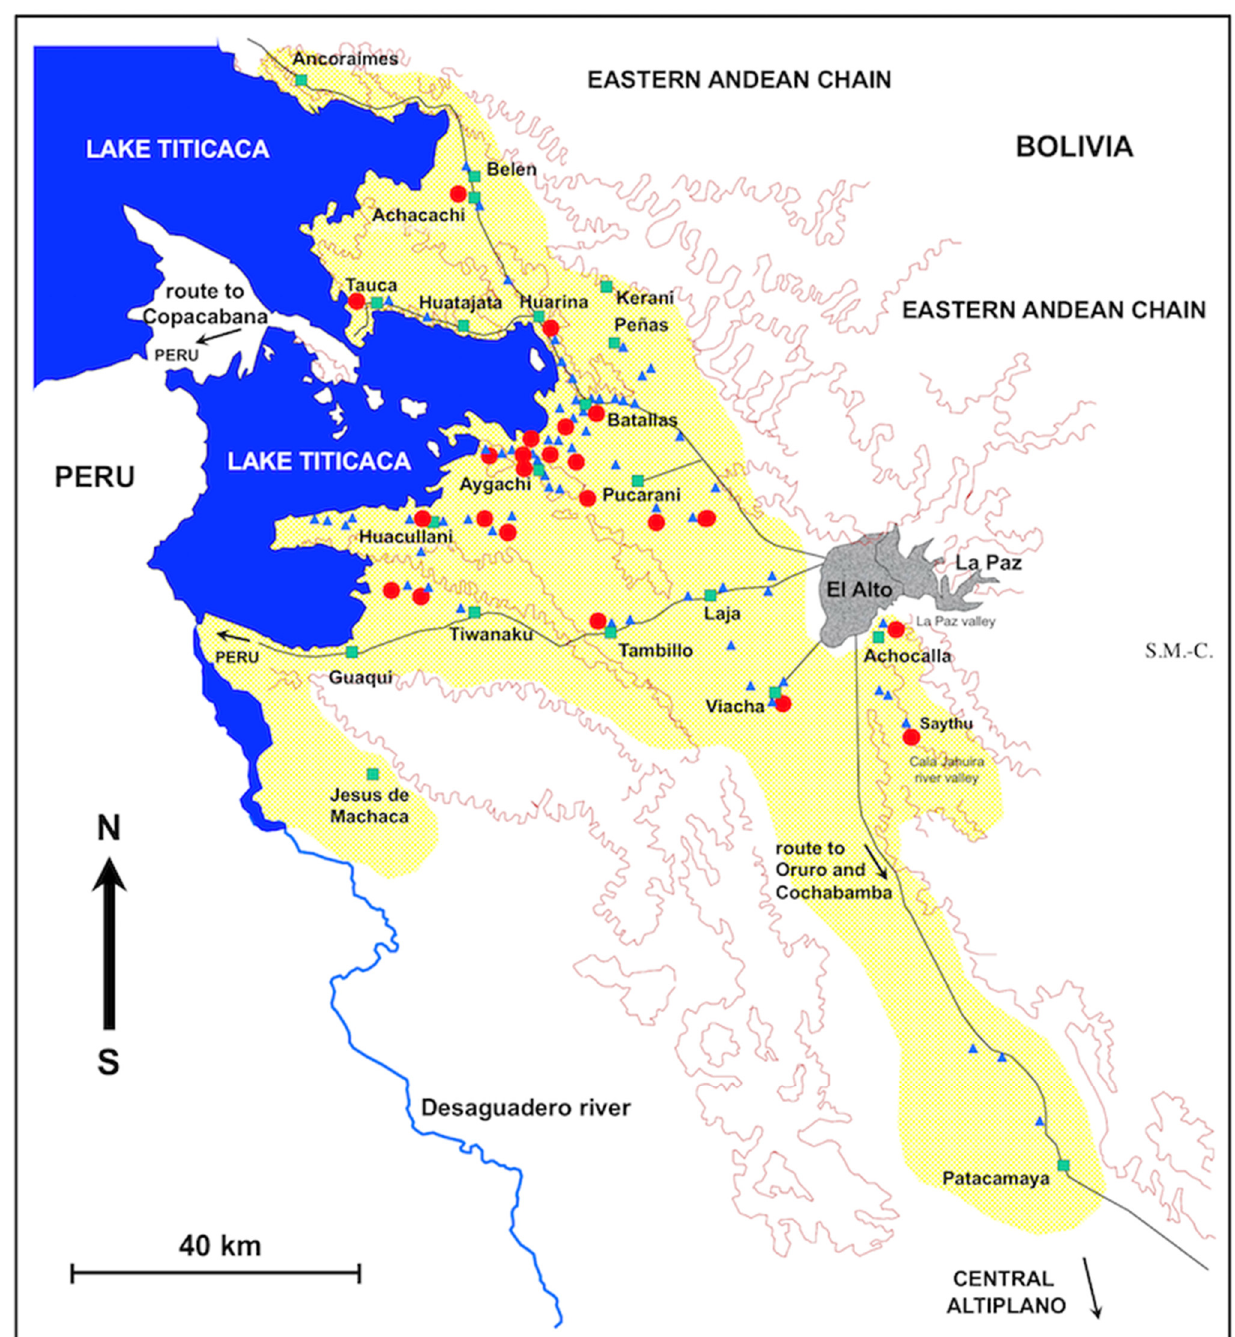
Figure 1. Map of the human fascioliasis hyperendemic area in the Northern Bolivian Altiplano, between Lake Titicaca and the city of El Alto and the valley of La Paz city: Yellow background = total prospected zone; red circles = localities presenting human infection by Fasciola hepatica ; blue triangles = freshwater collections inhabited by Galba truncatula snail vectors; green rectangles = important human localities. Original S. Mas-Coma.